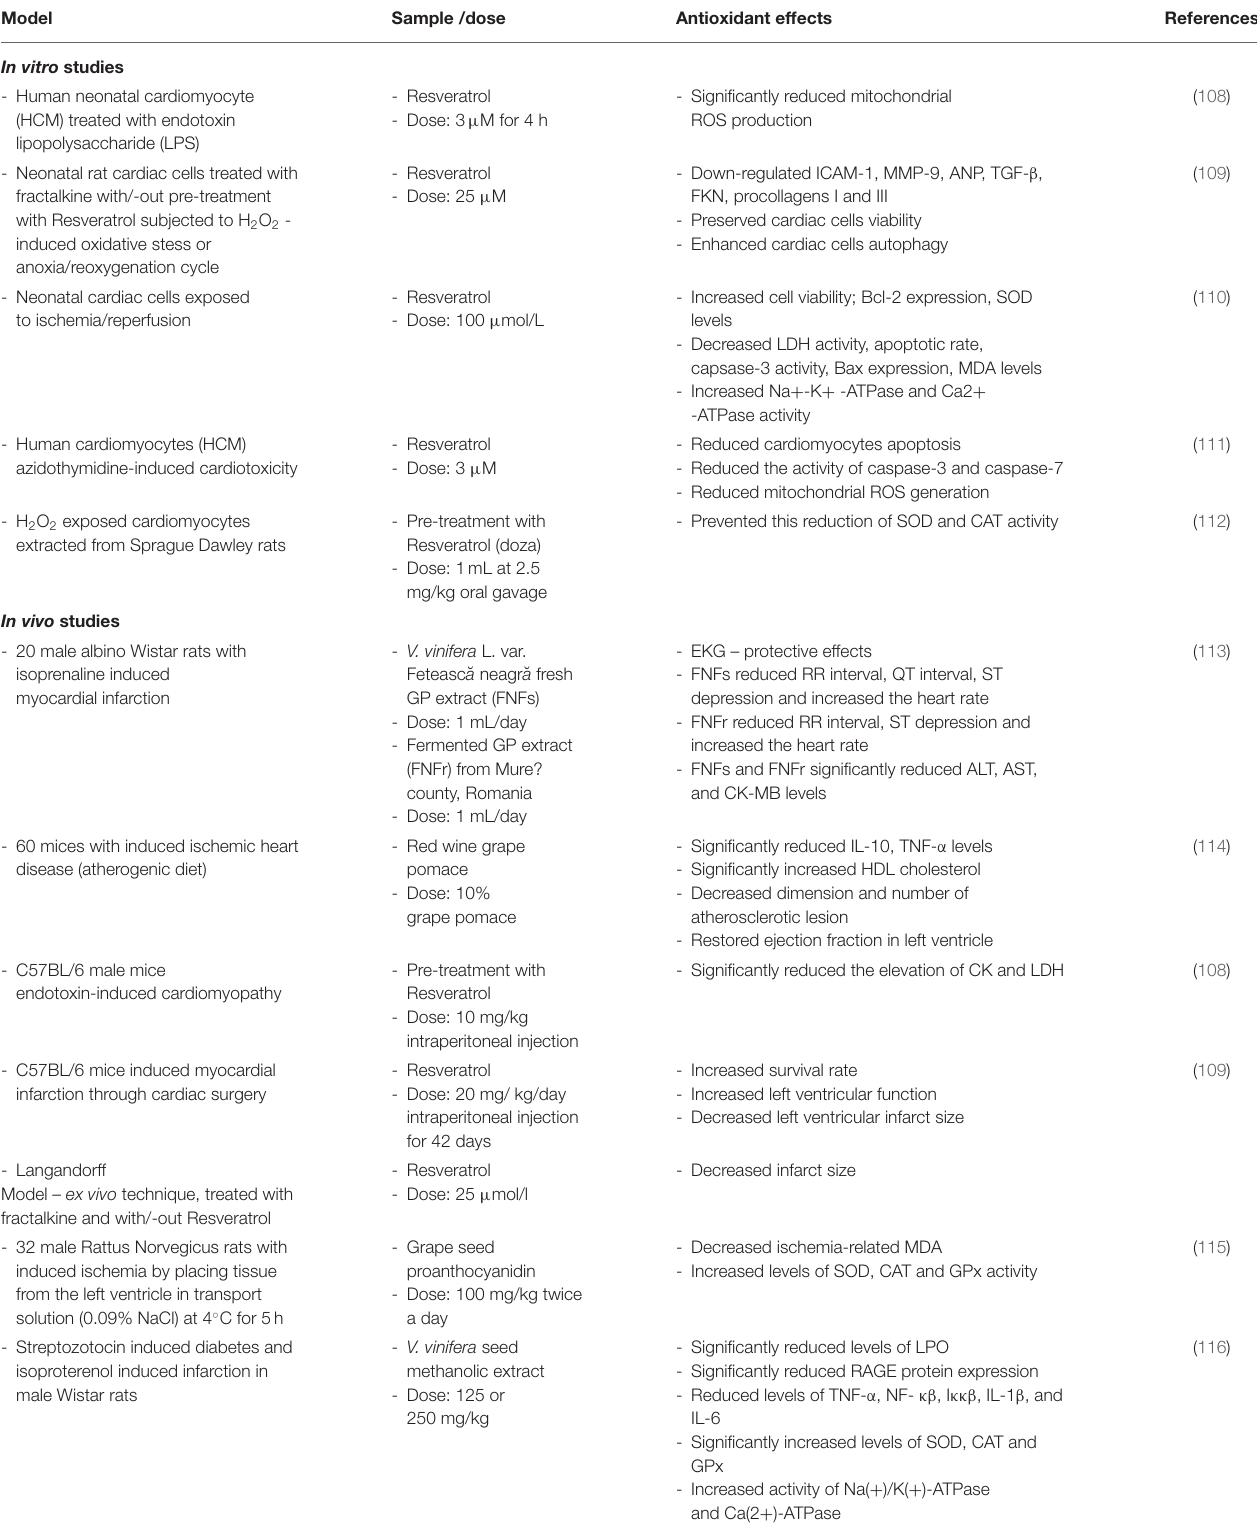
TABLE 2 | In vitro and in vivo evidence of antioxidant effect of resveratrol and polyphenols from grapevine and wine by-products.